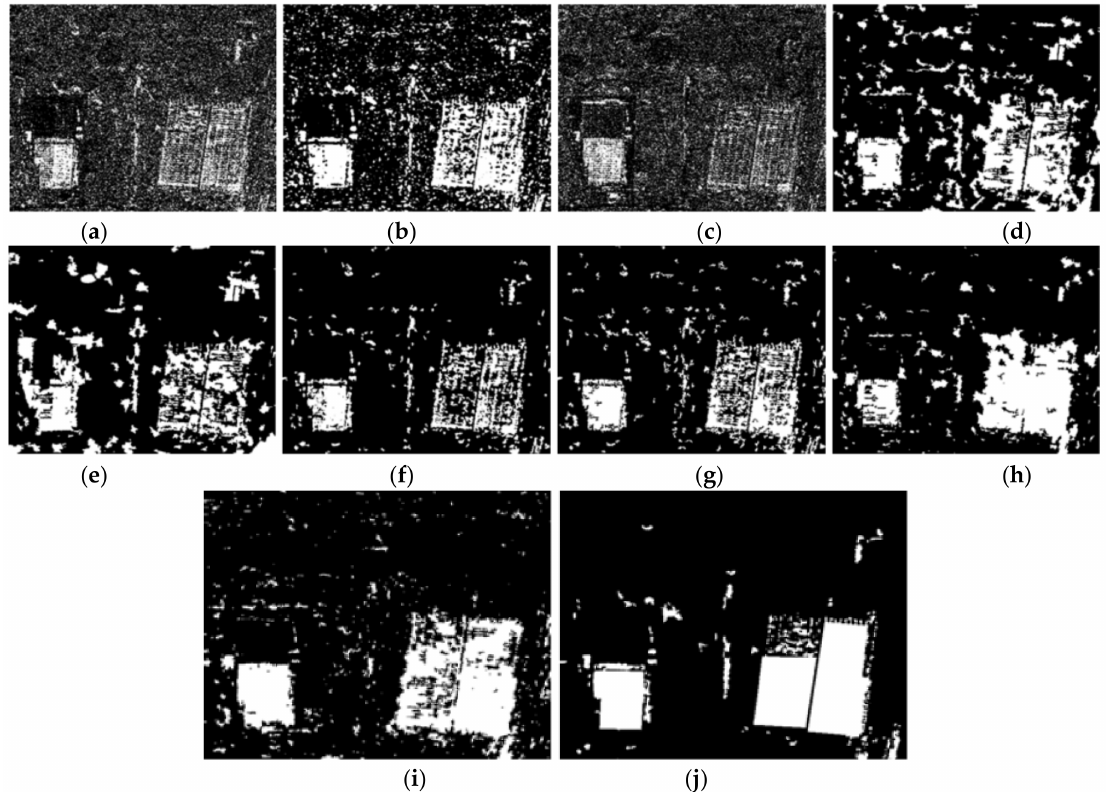
Figure 19. Binary change maps of Wuhan SAR images generated by different methods: ( a )